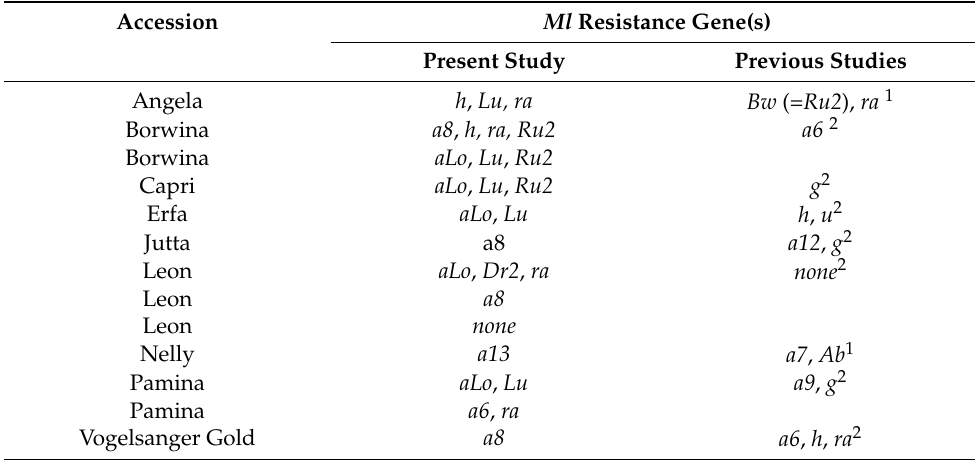
Table 3. Powdery mildew resistance genes found in identically designated winter barley accessions (discrepancies probably resulted from mislabeling of varieties). Accession Ml Resistance Gene(s) Present Study Previous Studies